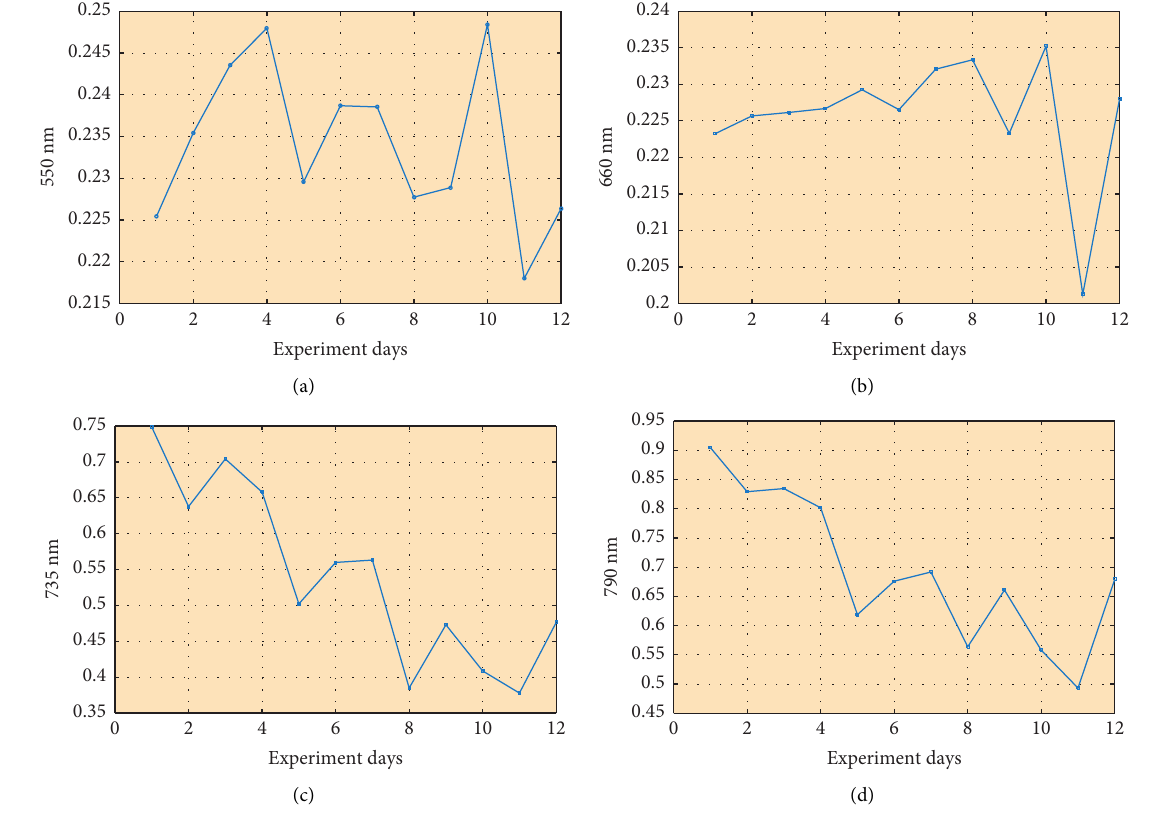
Figure 2: Schematic diagram of changes in multispectral reflectance values. (a) 550nm. (b) 660nm. (c) 730nm. (d)